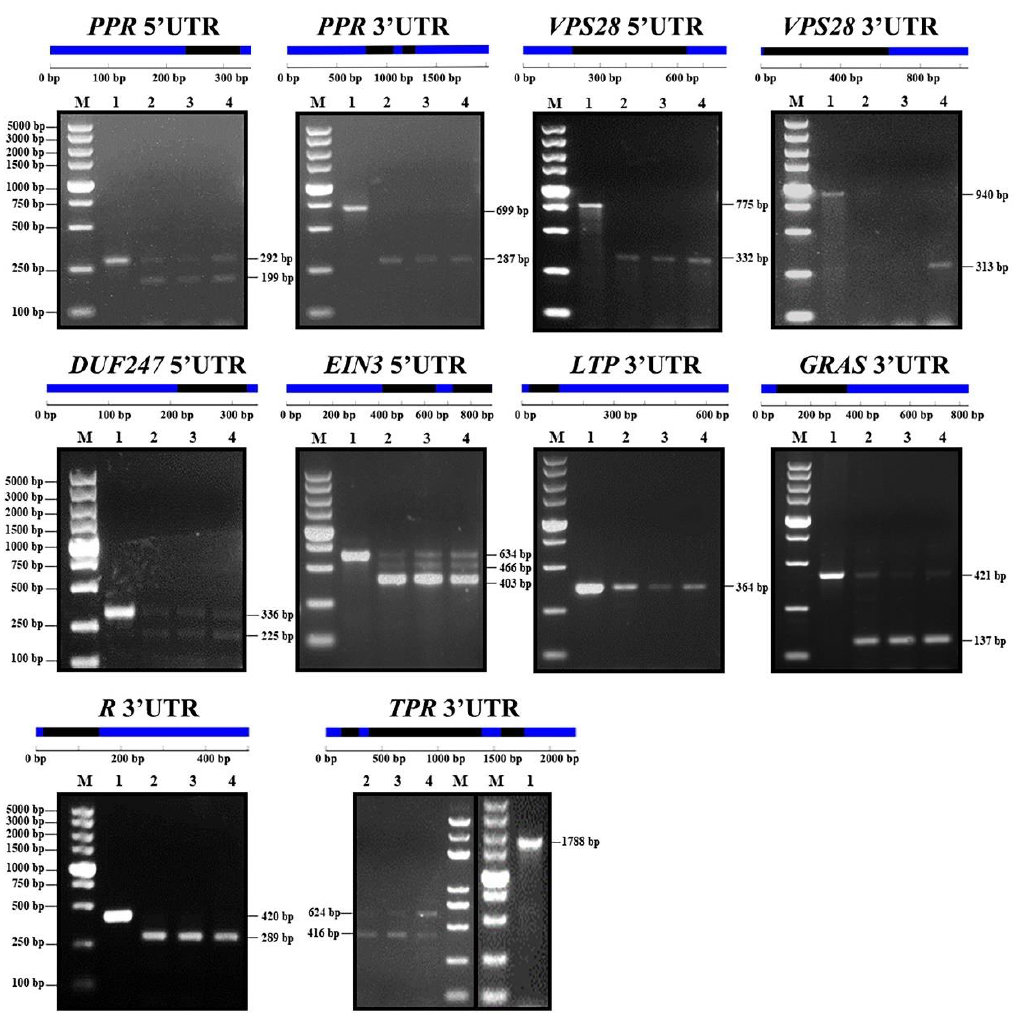
Figure 4. Electrophoresis detection results of the UTR introns (UIs) in untranslated regions (UTRs) of the eight selected genes. 1~4 respectively represents the PCR products using leaf gemomic DNA (gDNA), root complementary DNA (cDNA), leaf cDNA, and stem cDNA as template, respectively. M: DL5000 Marker; The UTR structure is available on the GSDS online website (http://gsds.cbi.pku.edu.cn/), with blue for exons and black for introns in UTR. PPR : Pentatricopeptide repeat superfamily protein (Cs6g01290.1), VPS28 : Vacuolar protein sorting-associated 28 (Cs2g06750.1), EIN3 : Ethylene-insensitive 3 (Cs2g29100.1), DUF247 : domain of unknown function 247 gene (Cs2g24990.1), GRAS : GRAS transcription factors (Cs8g18700.1), TPR : Tetratricopeptide repeat-like superfamily protein (Cs8g15200.1), R : Disease resistance protein (Cs5g21990.1) and LTP : Lipid transfer protein (Cs5g09070.2).